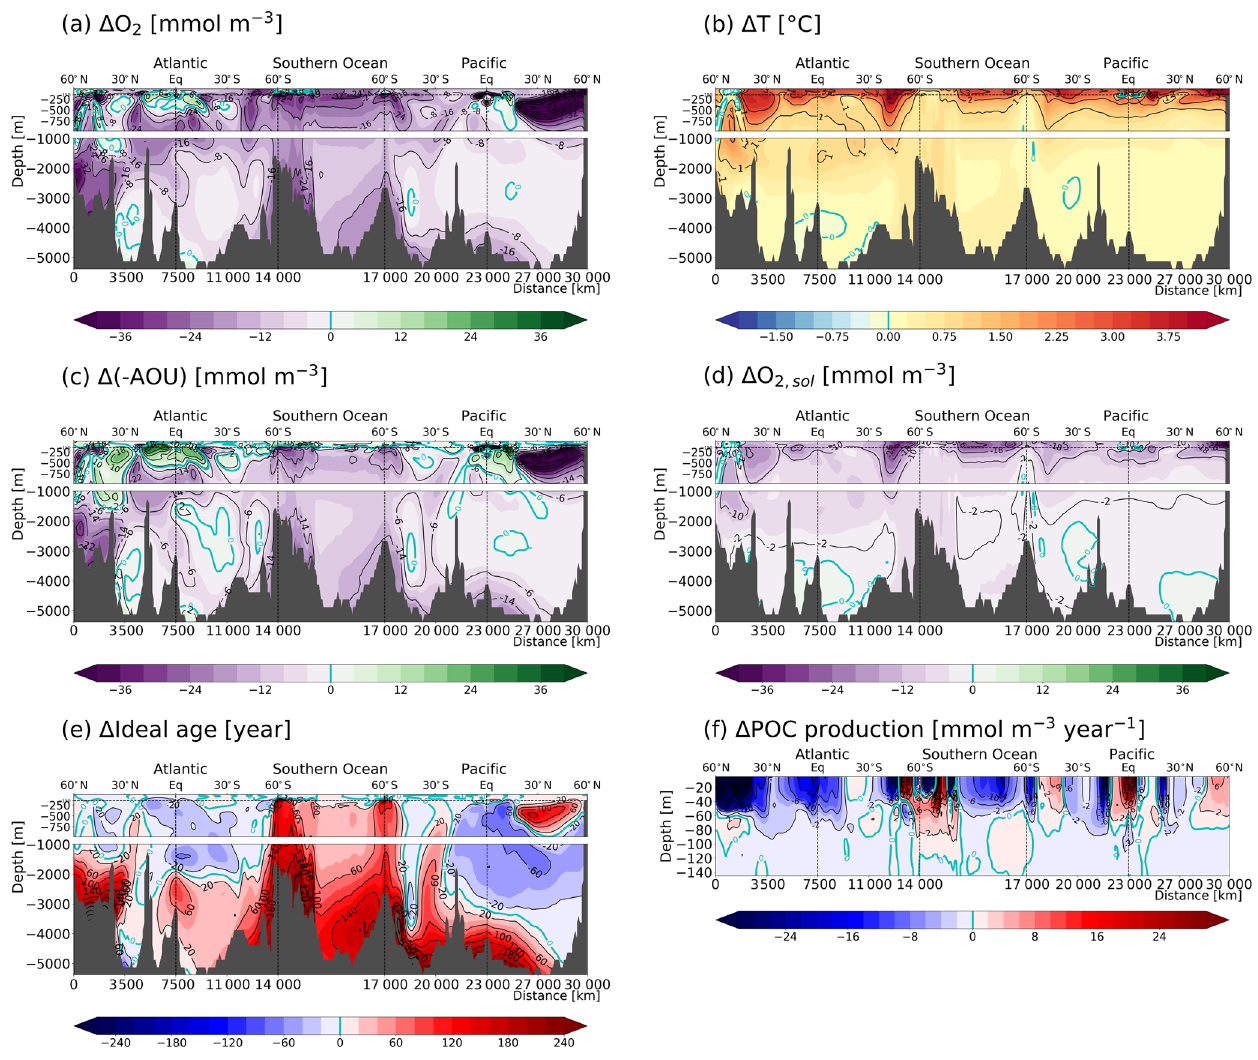
Figure 9. Anthropogenic changes ((2070–2099CE) minus (1720–1800CE)) in (a) O 2 , (b) T , (c) − AOU, (d) O 2 , sol , (e) ideal age and (f) POC production. The sections are taken along 25 ◦ W in the Atlantic, 60 ◦ S in the Southern Ocean and 150 ◦ W in the Pacific (Figs. 3b, d and 8; magenta